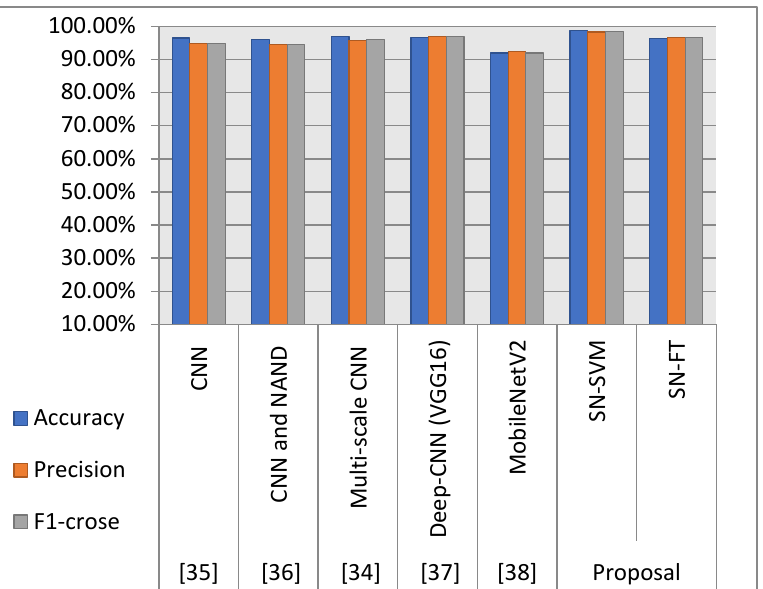
Figure 12. Comparison of the related works based on accuracy, precision, and F1-score.